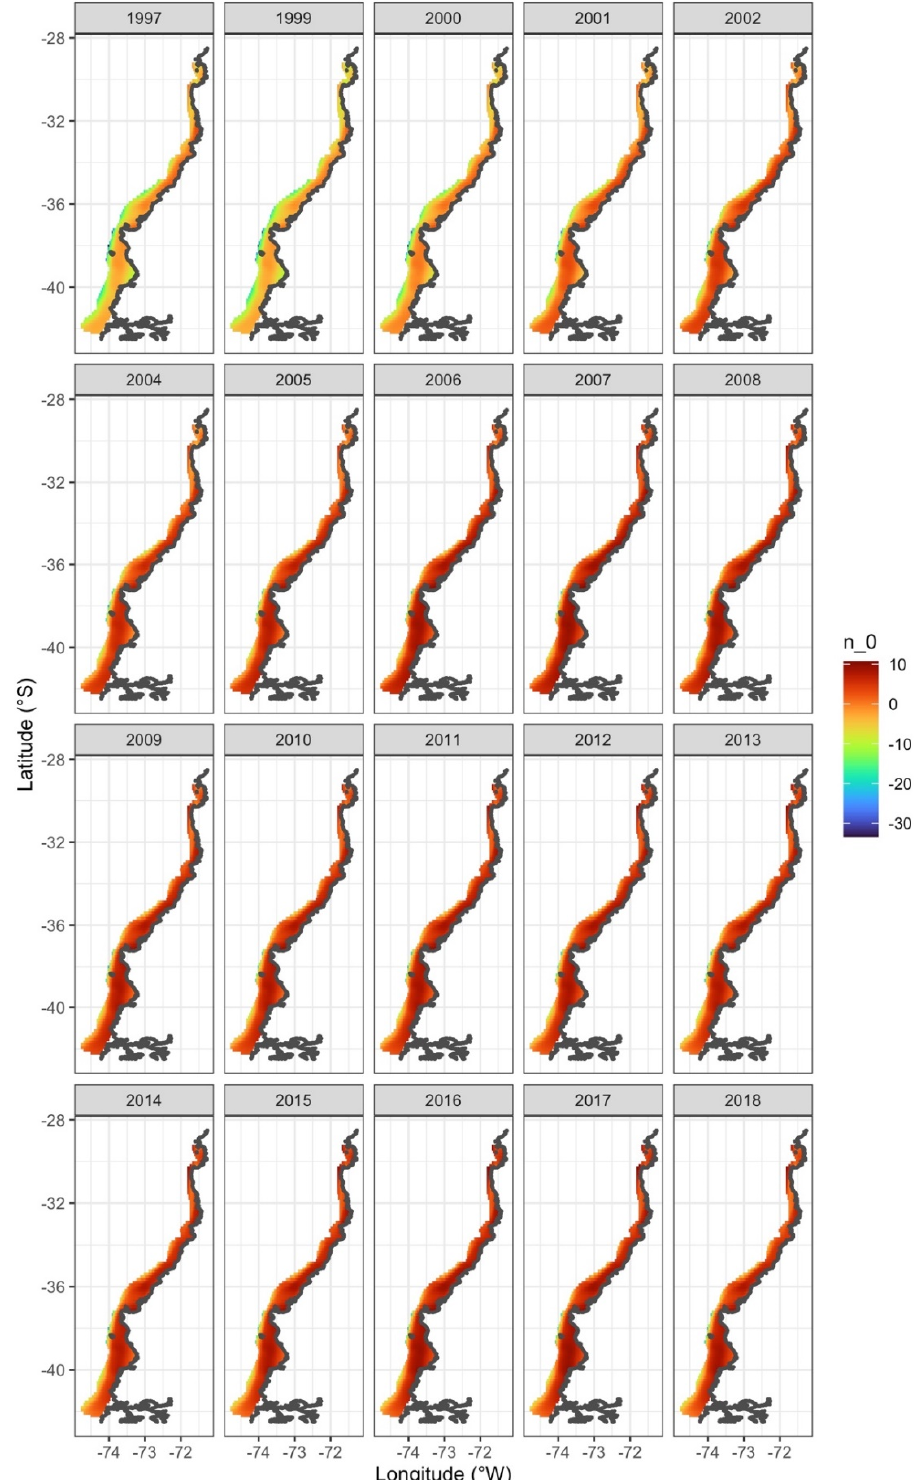
Figure 4. Spatiotemporal distribution of the abundance of Chilean hake juvenile of age 0, from 1997 to 2018 (Model M0.7, Table 2).